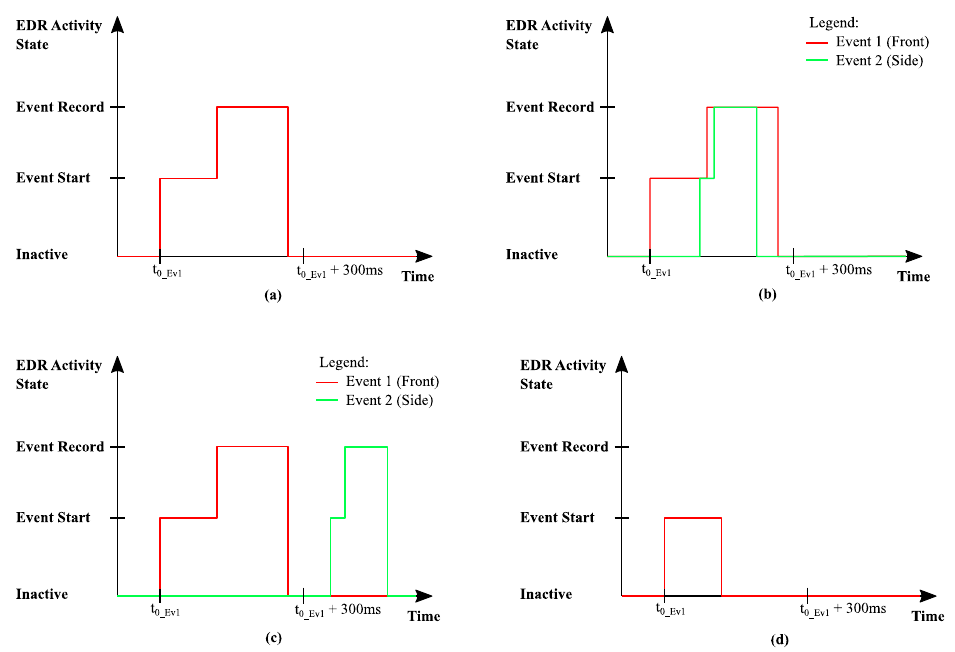
6 Figure 4. Exemplary mapping of crash activity to airbag algorithm states and EDR activity states. The purpose of the given example is to illustrate how the crash pro ‐ gress—represented by the acceleration—is interconnected with the EDR activity states. Here, the airbag algorithm state “wake ‐ up” is triggering the EDR event start (time zero t 0 ). Also, it is possible that the cumulative delta ‐ V triggers the EDR event start. However, whether the event has to be recorded or not is depending on the deploy decision of the airbag algorithm. The end of an event is, again, depending on the algorithm state (reset) and the cumulative delta ‐ V [1]. For the purpose of easier visualization, in the following sections of this work only the EDR activity states are displayed—the general behavior is as described in Figure 4. An overview about possible EDR activity states and the occurrence of multiple